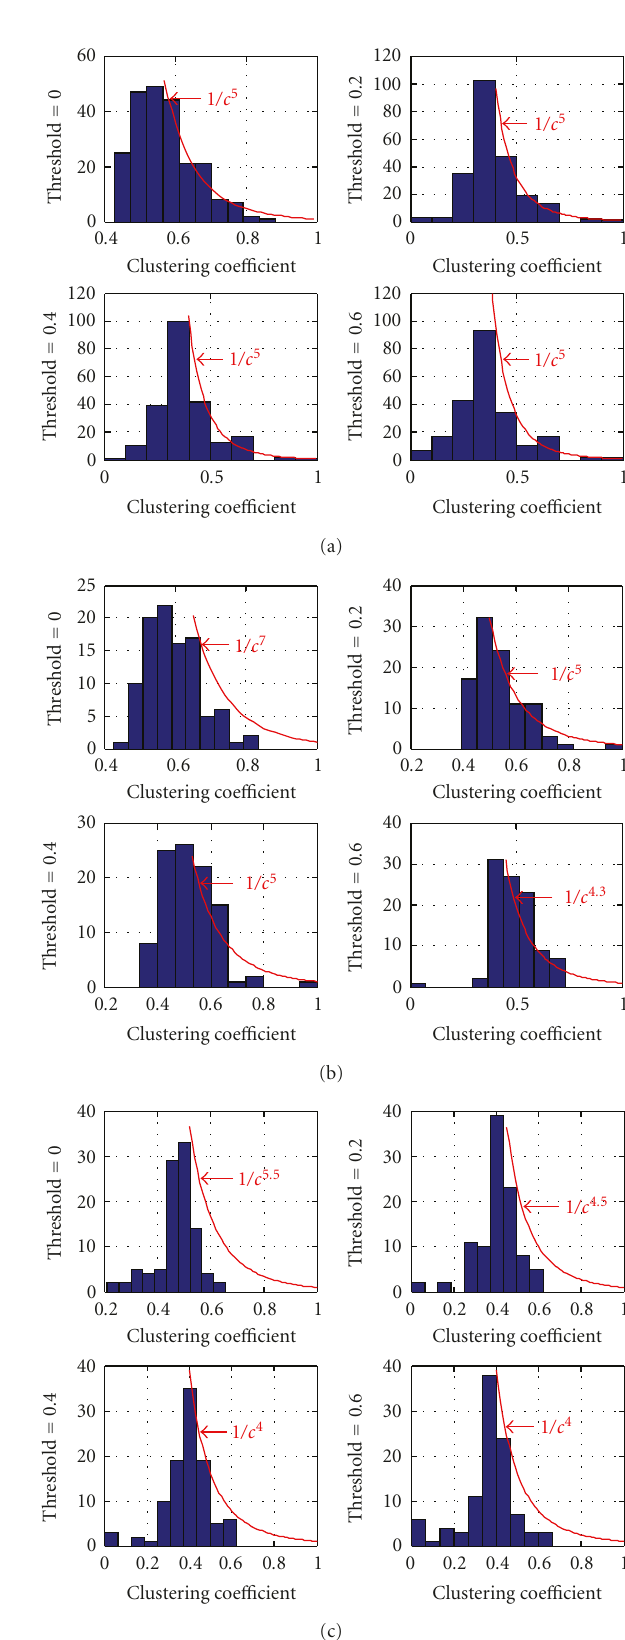
Figure 6: Estimated probability distribution of clustering coe ffi - cient: (a) simulation data; (b) real dataset A; (c) dataset B.